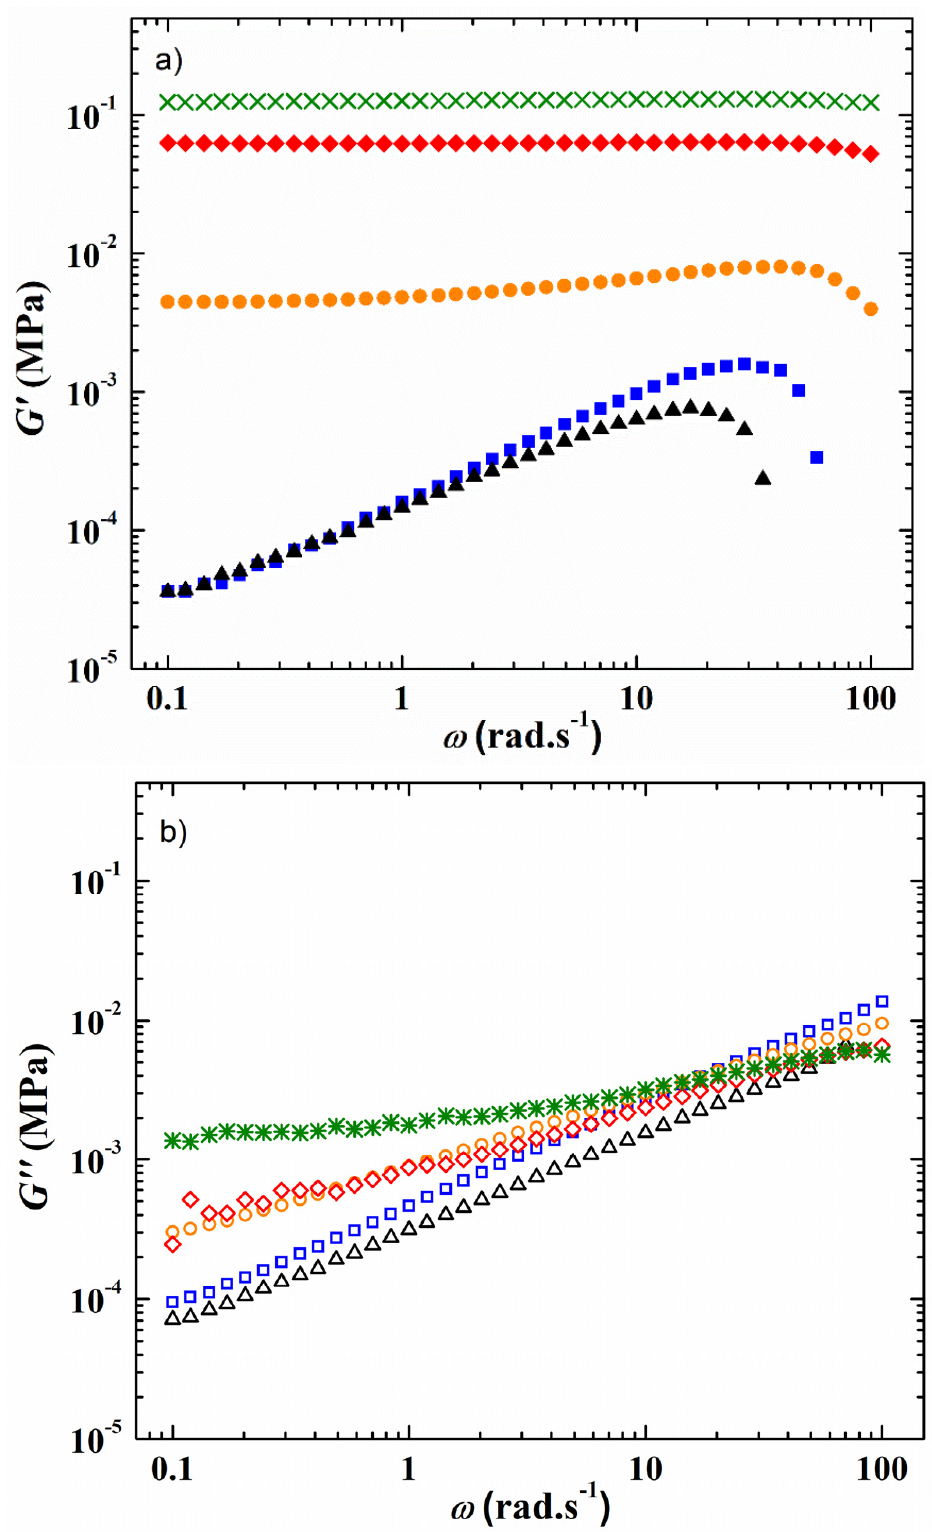
Figure 2. Frequency response at 75 °C and at a strain value fixed at 1% of ( a ) the storage modulus G ′ and ( b ) the loss modulus G ′′ of the HySI electrolytes. The symbols correspond to w VSTFSILi value of (green cross) 15, (red diamond) 17, (orange circle) 20, (black triangle) 25, and (blue square) 33.